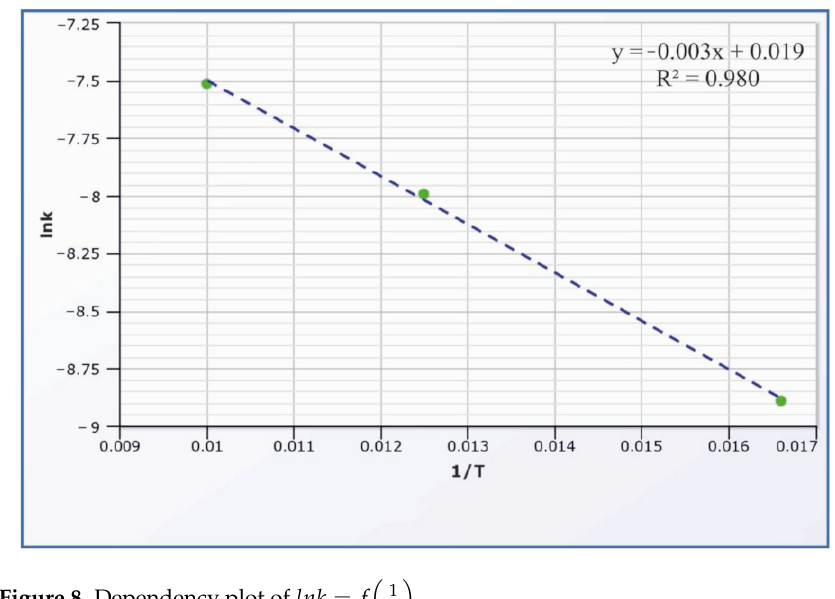
Figure 8. Dependency plot of lnk = f According to the data in Figure 8 and Formula (3), the “apparent” activation energy of the potassium humate extraction process from coal mining waste wascalculated. As